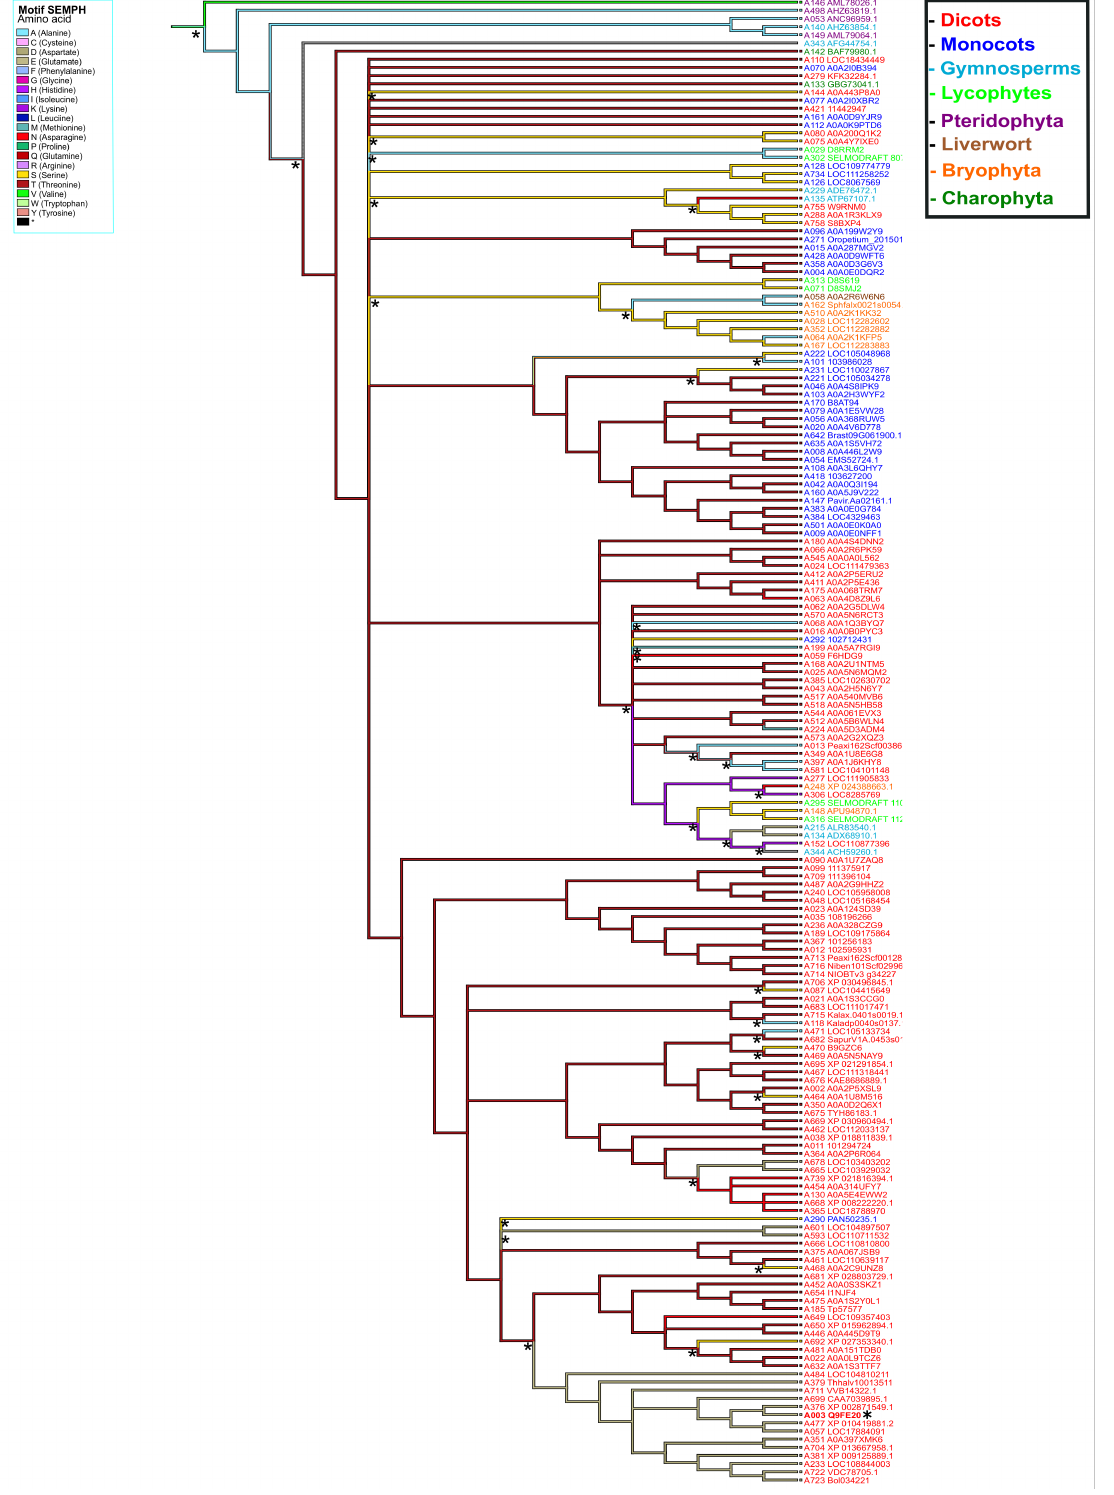
Figure 9. Ancestral state reconstruction in PBS1 orthologs based on the SEMPH motif. Ancestor reconstruction was performed with maximum parsimony using as ancestral character the PBS1 amino acid sequence. Reconstruction of ancestral state in amino acid 297 position of PBS1. Branch color indicates the evolutionary divergence of the ancestral amino acid. Accession numbers are shown in red. Transitions and reversions are indicated with asterisks above nodes. This figure shows the ancestral state of glutamic acid (E). Arabidopsis is indicated with asterisk (*) and bold red. For ancestry of other amino acids, see Supplementary Figures S4 and